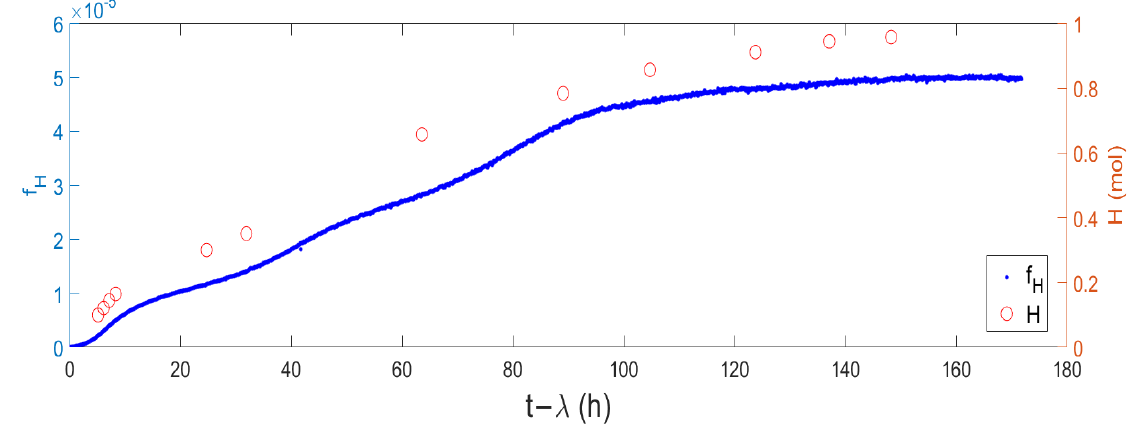
Figure 3. f H function ( left ) and cumulated hydrogen production ( right ).